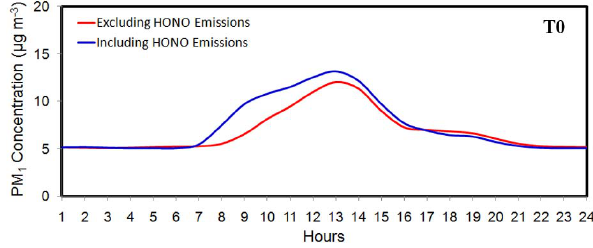
Fig. 13. Comparison of model episode average diurnal predictions for PM 1 oxygenated organic aerosols at T0 using an emission inven- tory with HONO emissions (red line) and without HONO emissions (blue